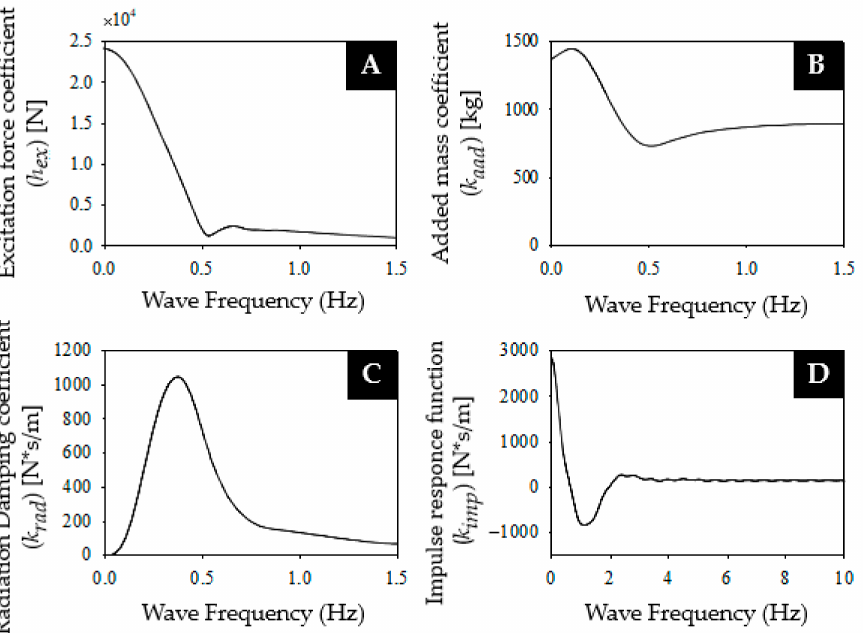
Figure 2. Hydrodynamic parameters of WEC device. ( A ) Excitation force coefficient, ( B ) Added mass coefficient, ( C ) Radiation damping coefficient, and ( D ) Impulse response